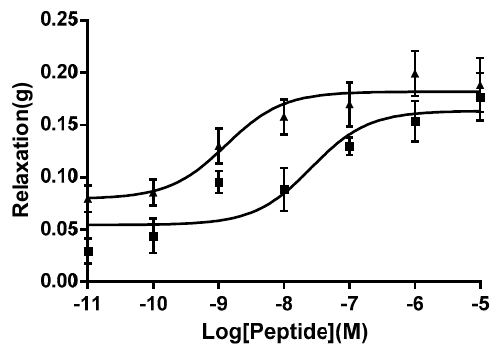
Figure 4. Dose–response curves of relaxation effects on phenylephrine stimulated rat tail artery smooth muscle preparation in the Bradykinin ( ▲ ) or WL-8 amide ( ■ ). Each point represents the mean and standard error. (4 repilicates, 3 individual experiments.) EC 50 of Bradykinin: 1.29 nM; EC 50 of WL-8 amide: 25.98 nM.